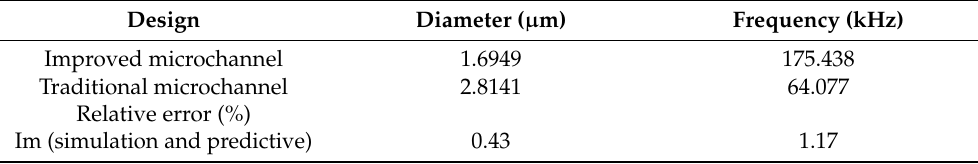
Table 3. Comparison between numerical and RBF predicted